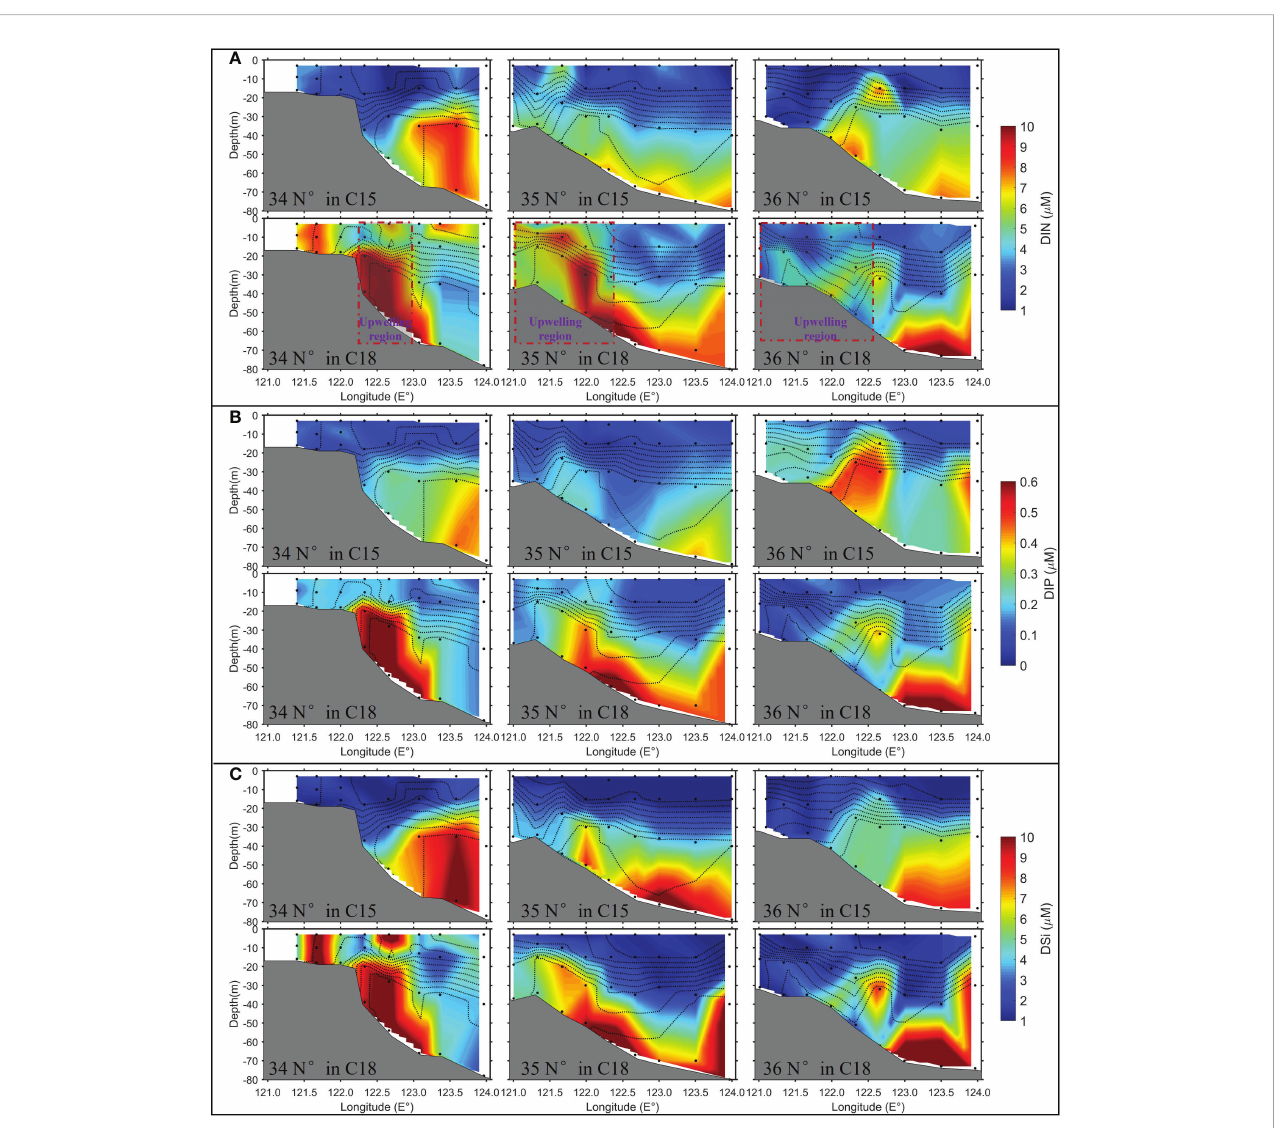
FIGURE 7 The patterns of DIN (A) , DIP (B) , and DSi (C) concentrations along the three transects (34°N, 35°N and 36°N) during C15 (upper panels) and C18 (lower panels). The black dash lines are isotherms (the interval of the isotherms is 2 °C). The red dashed boxes in (A) denote the upwelling region at water depths between 25 m and 62.5 m, which were derived from the analytical solution of wind-driven upwelling.